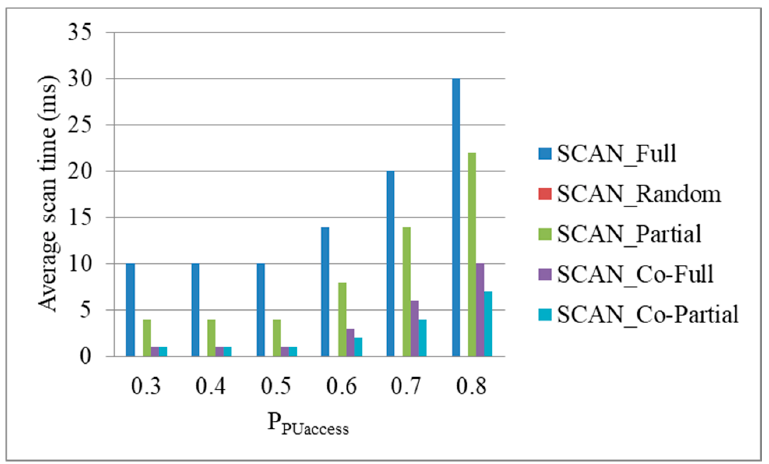
Figure 18. Average scan time under different PU cars access network probabilities (PU number = 10, V = 10, SU number = 10).